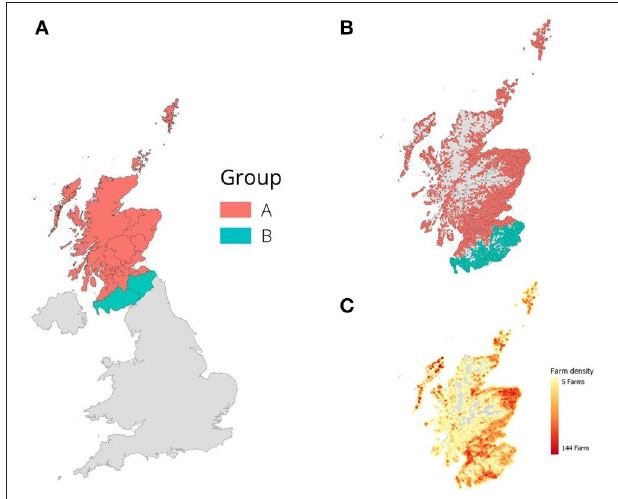
FIGURE 1 | Group division of local authorities in Scotland. (A) UK map and categorizing local authorities in Scotland into two, Group A ( G A ) and B ( G B ). (B) Distribution of farms. (C) Heat map of farm density pointing that animal holdings are heavily distributed in the south and east of